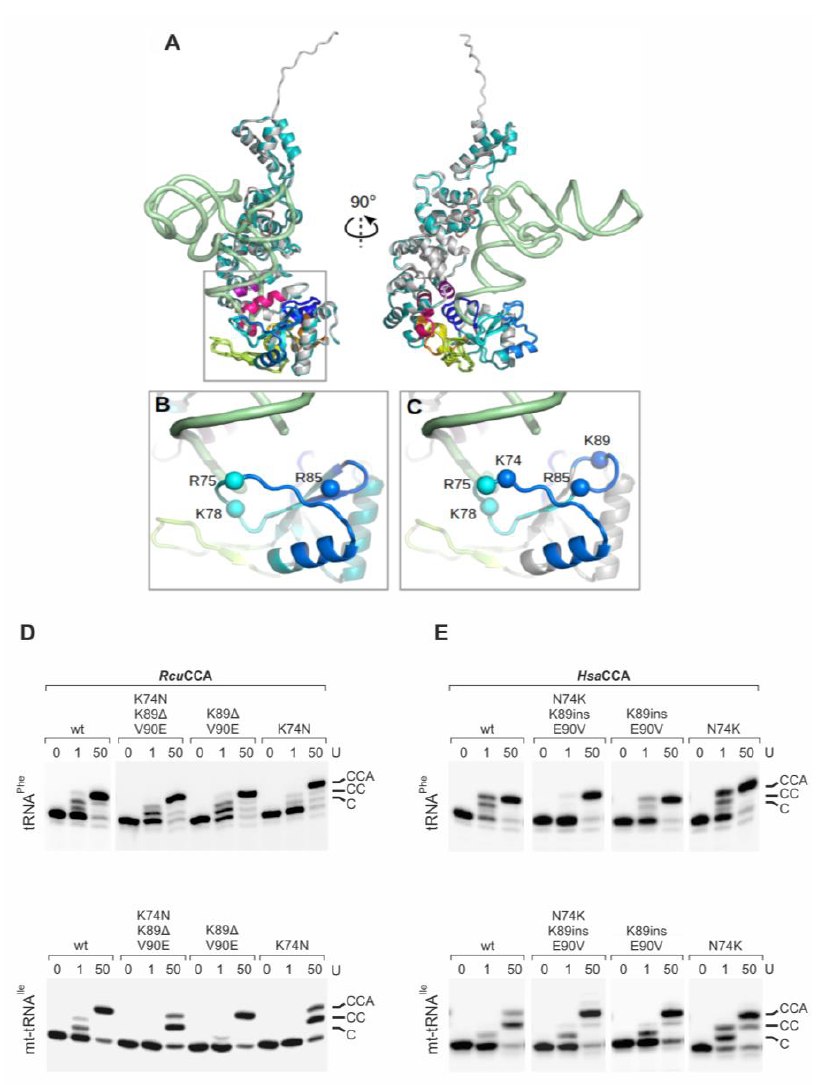
Figure 5. The β -turn in Hsa CCA and Rcu CCA enzymes. ( A ) Superimposed full-length models of Hsa CCA (cyan) and Rcu CCA (light gray) with the backbone of a bound tRNA (green) in two perpendicular views. The tRNA position was obtained by superimposing the A-adding enzyme:tRNA-CC complex from Aquifex aeolicus onto the human enzyme [34,35,70]. Motif A (dark blue), β -turn region (medium blue), β -turn (light blue), B / A motif and flexible loop (green), motif B (yellow), motif C (orange), motif D (red) and motif E (violet) are indicated. ( B , C ). Zoom into the β -turn region and the tRNA 3′ -end (corresponding to the squared region in ( A ) of Hsa CCA ( B ) and RcuCCA ( C ). Spheres represent the C α positions of positively charged residues (K and R). Rcu CCA carries two additional lysines at positions 74 and 89 that might contribute to tRNA binding and primer positioning. Model is based on the crystal structure of the A-adding enzyme from Aquifex aeolicus [34]. ( D ) Enzymatic activity of Rcu CCA carrying mutations K74N, K89 Δ /V90E and K74N/K89 Δ /V90E. 0, 1,